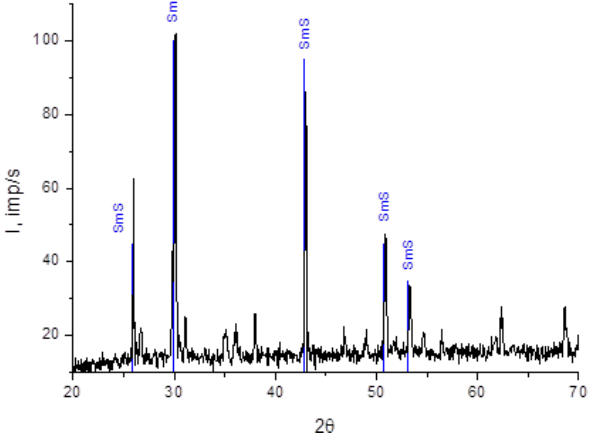
Figure 1. Diffractogram of polycrystalline SmS.